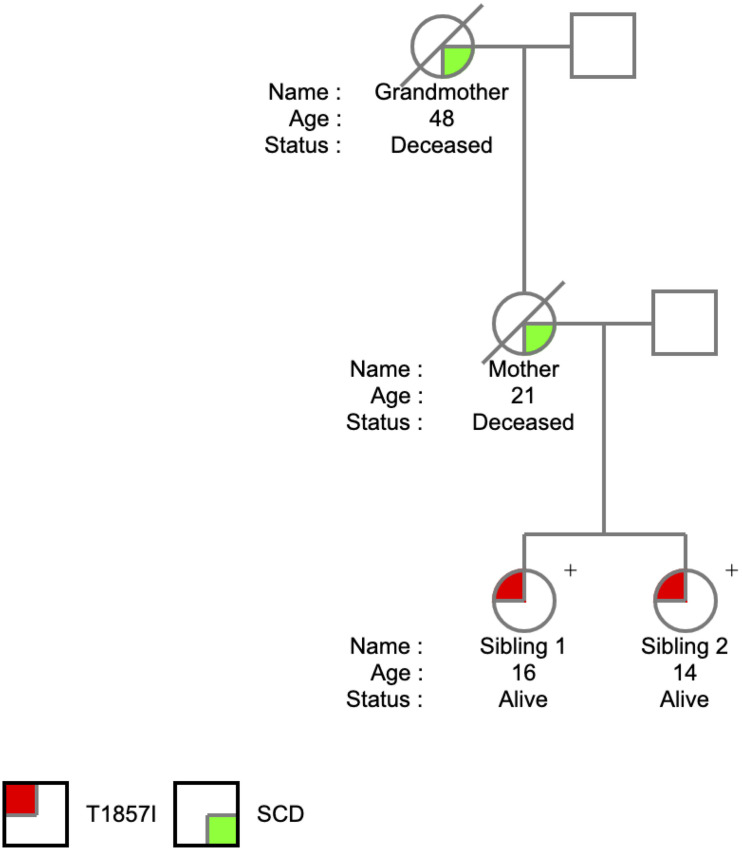
Pedigree of the T1857I Variant in Nav1.5.